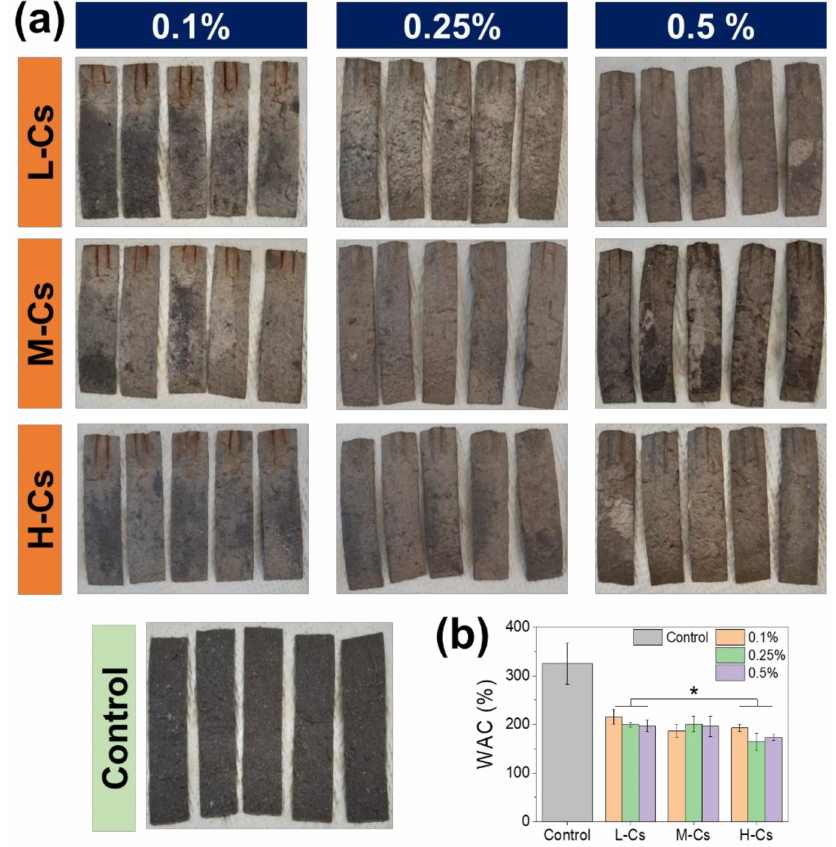
Figure 7. ( a ) Photographs of plant paper samples coated with chitosan with varying concentrations and molecular weights after immersing them in hot water. ( b ) Water absorption capacity (WAC) values of plant papers coated with chitosan (* p < 0.05). Uncoated paper was used as